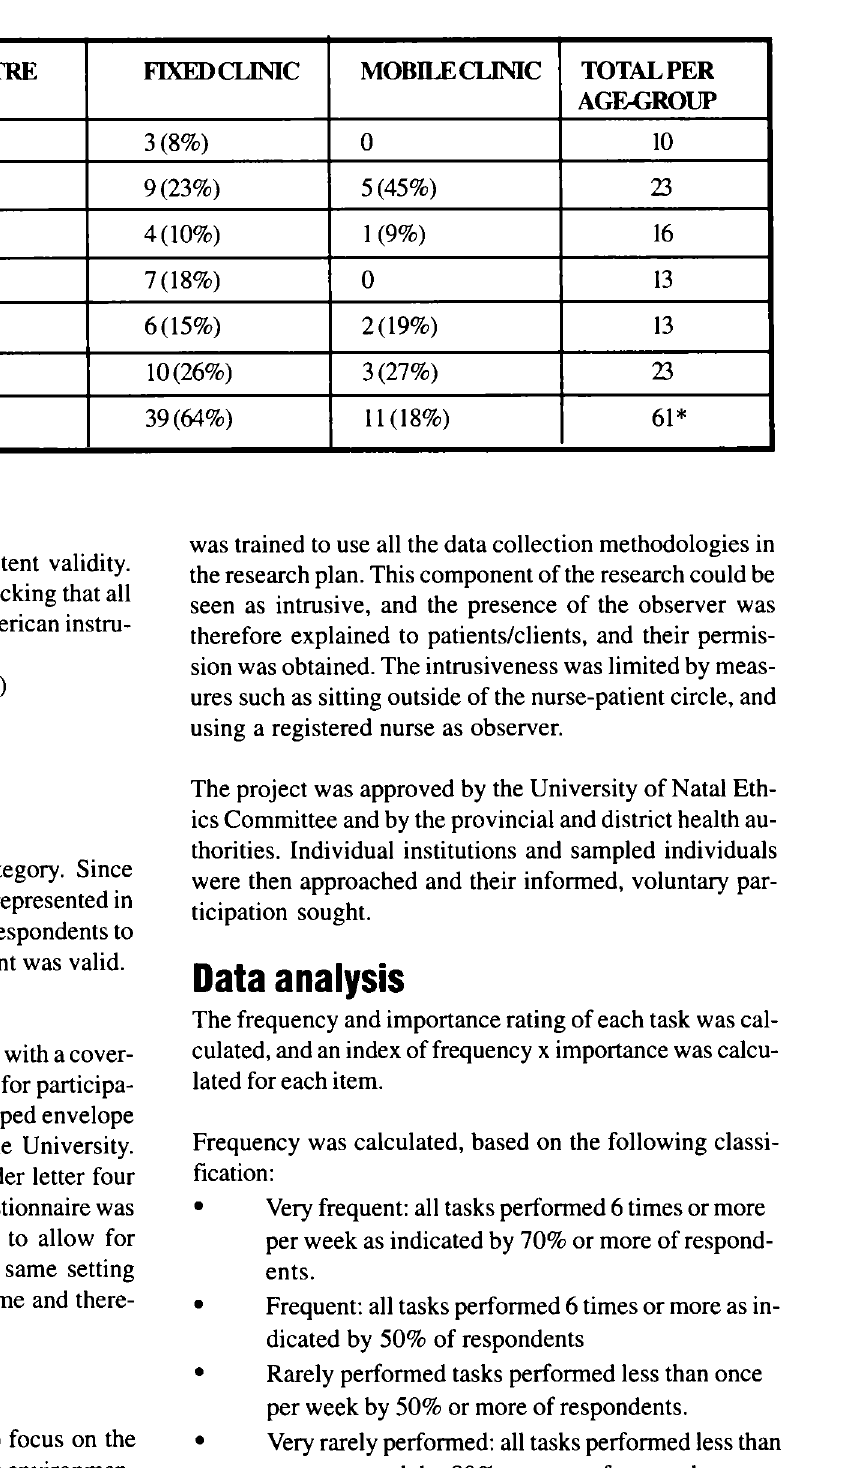
Table 2.2 Age and workplace of respondents with column % (n = 6